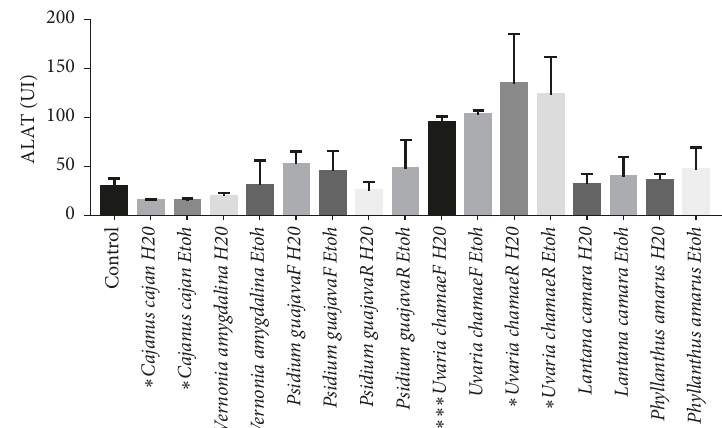
Figure 4: Effects of extracts on alanine aminotransferase.